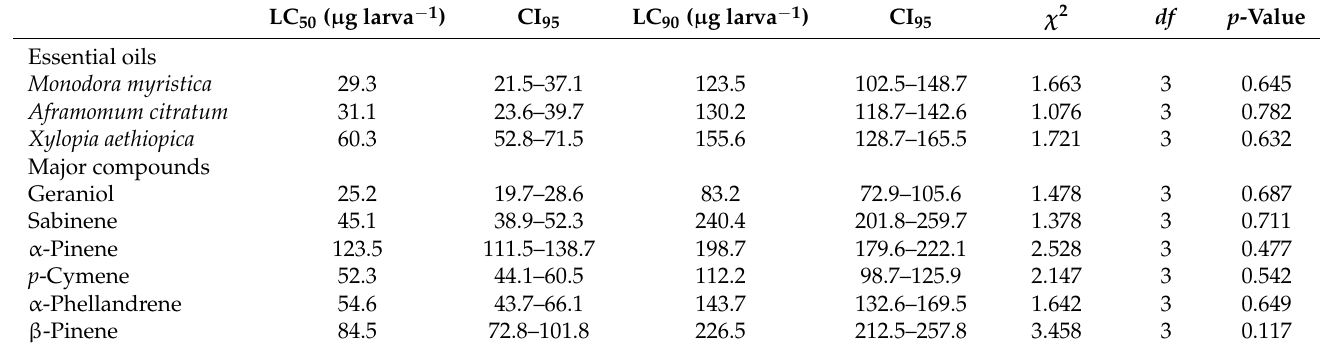
Table 3. Insecticidal activity of Monodora myristica , Aframomum citratum , and Xylopia aethiopica essential oils and their major constituents on Spodoptera littoralis third instar larvae.